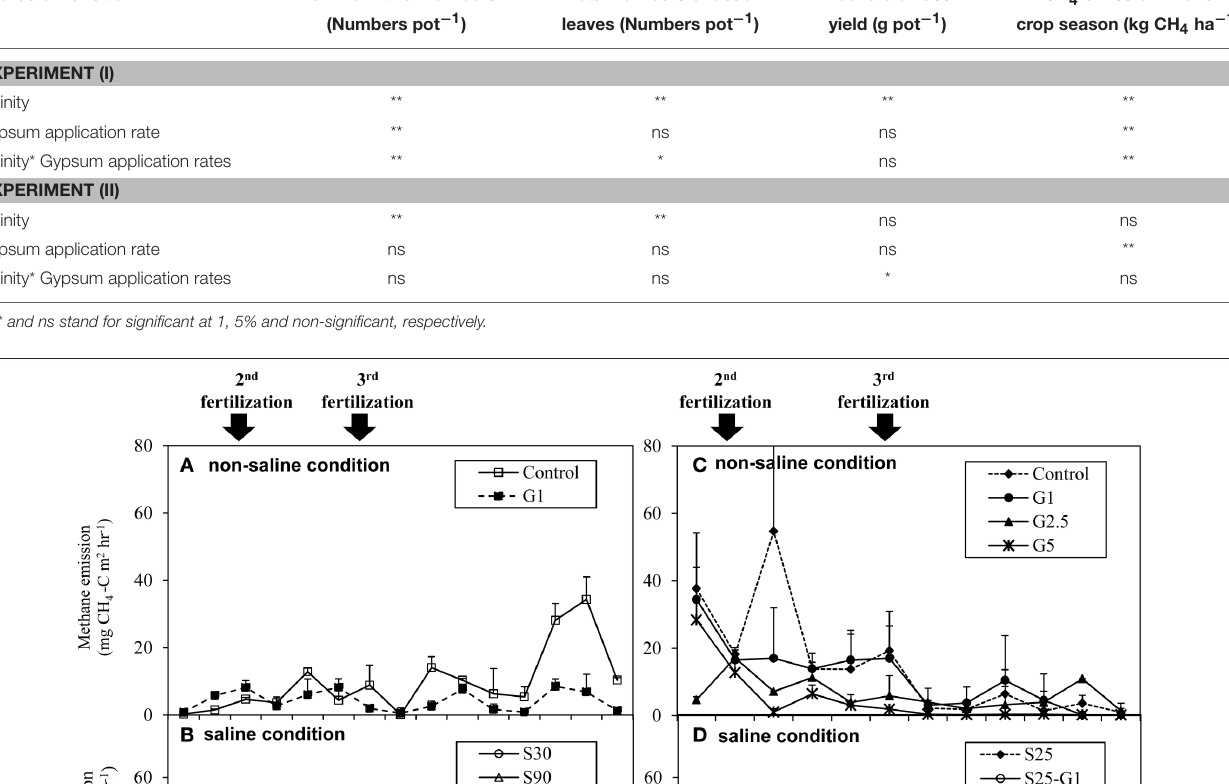
TABLE 4 | Results of ANOVA test for CH 4 emission and crop growth. Source of variation